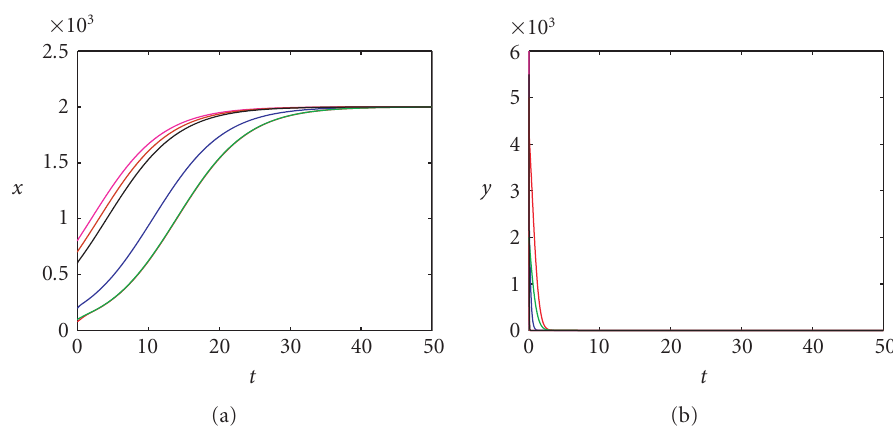
Figure 3.18. The parameters used here are the same as those for Figure 3.17, except that c = 1 . 2. The fixed point is a stable node with x 0 ≈ 2000, y 0 ≈